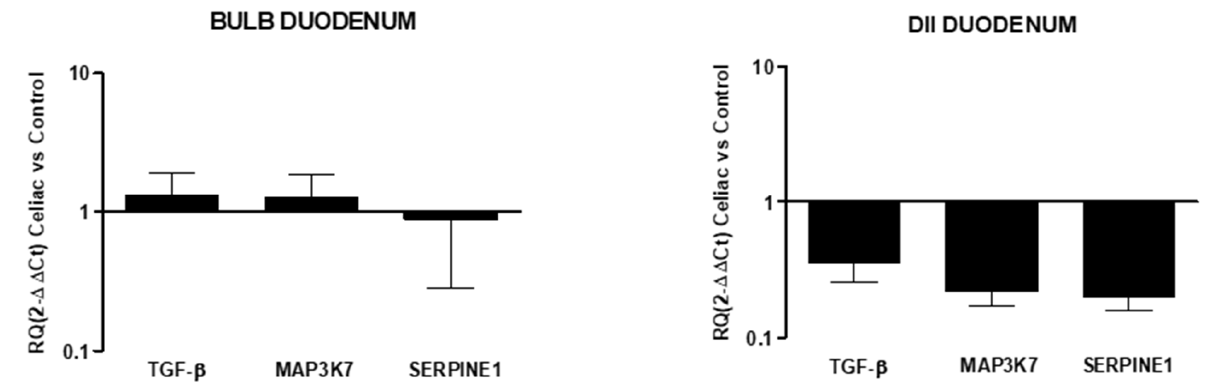
Figure 5. Relative expression of mRNA encoding for TGF- β , MAP3K7, and SERPINE1 in mucosal tissue from the DII and bulb duodenum. Data are determined by qPCR (log 10 2 − ∆∆ CT vs. control). Data are expressed as the mean ± SE of four experiments.